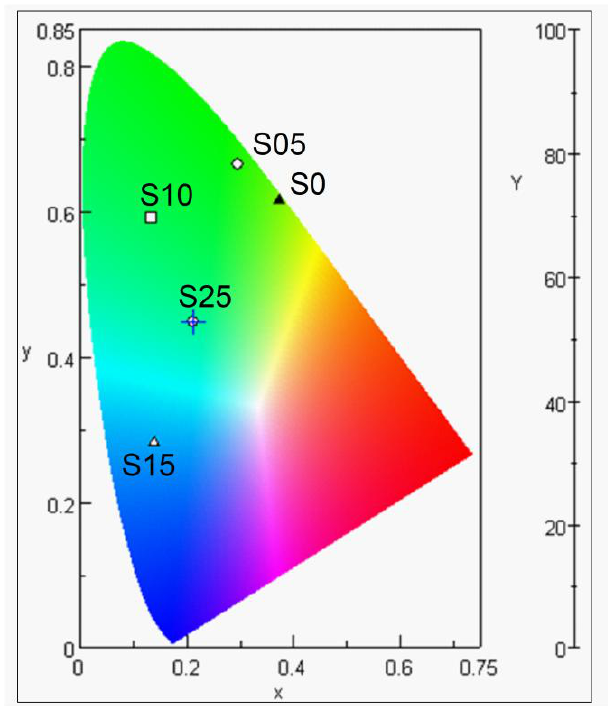
Figure 14. Chromaticity diagram for the emission color of the samples doped with different percentages of S.